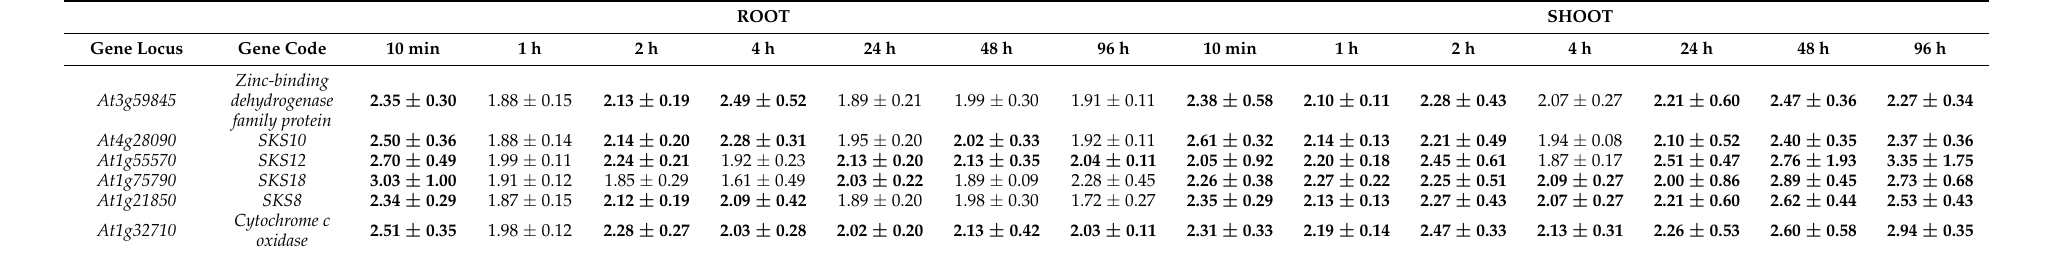
Table 2. Group B. Genes that are upregulated in shoots mostly at all times and upregulated in roots mainly at earlier times. Genes were selected based on a fold change ≥ 2 or ≤ 0.5 in at least one time point. Values are expressed as the mean and standard deviation ( ± ), values with a fold change ≥ 2 or ≤ 0.5 are indicated as boldfaced numbers. ROOT